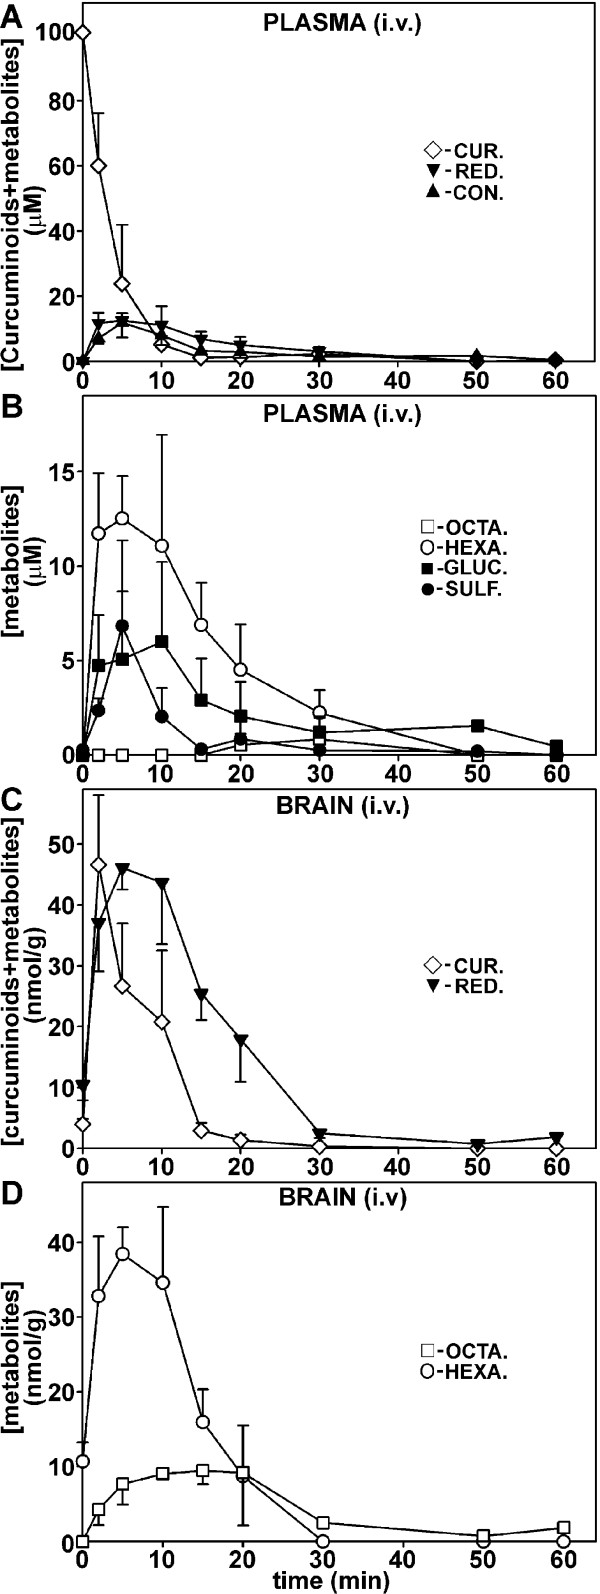
Concentration of curcuminoids and metabolites in plasma (uM) and brain (nmol/g) after i.v. injection. (A) Time course of total curcuminoids (◊), reduction products (hexa- + octacurcuminoids, ▼), and monoconjugates (sulfates + glucuronides, ▲) in plasma. (B) Time course of individual metabolite concentrations in plasma: hexahydrocurcuminoids (○), octahydrocurcuminoids (□), curcuminoid monoglucuronides (■), and curcuminoid monosulfates (●). (C) Time course of total curcuminoids (◊) and reduction products (▼) in brain. (D) Time course of hexahydro- (○) and octahydrocurcuminoids (□) in brain.